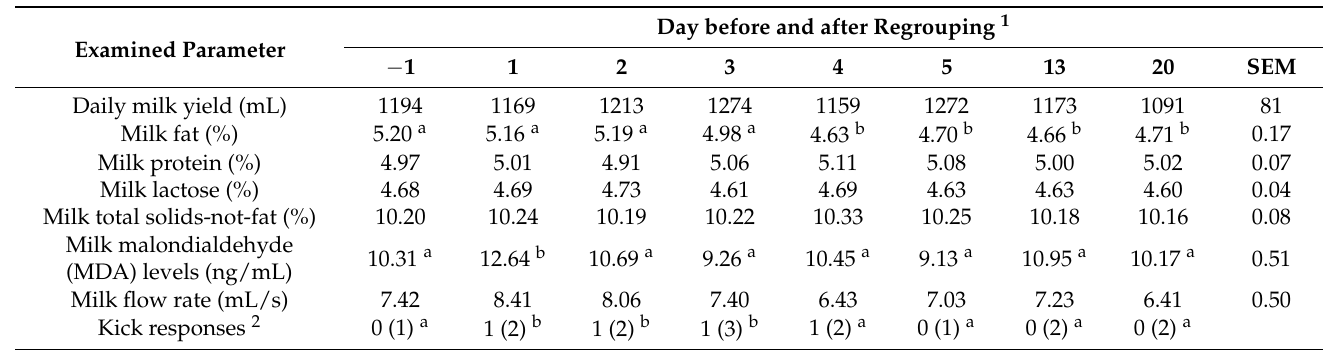
Table 1. Effect of regrouping on milk yield, composition, oxidative stability, flow rate and kick responses in Chios ewes.